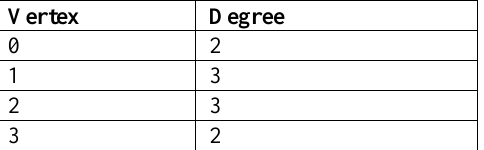
Table 3: The degrees of the vertices in the graph of Figure